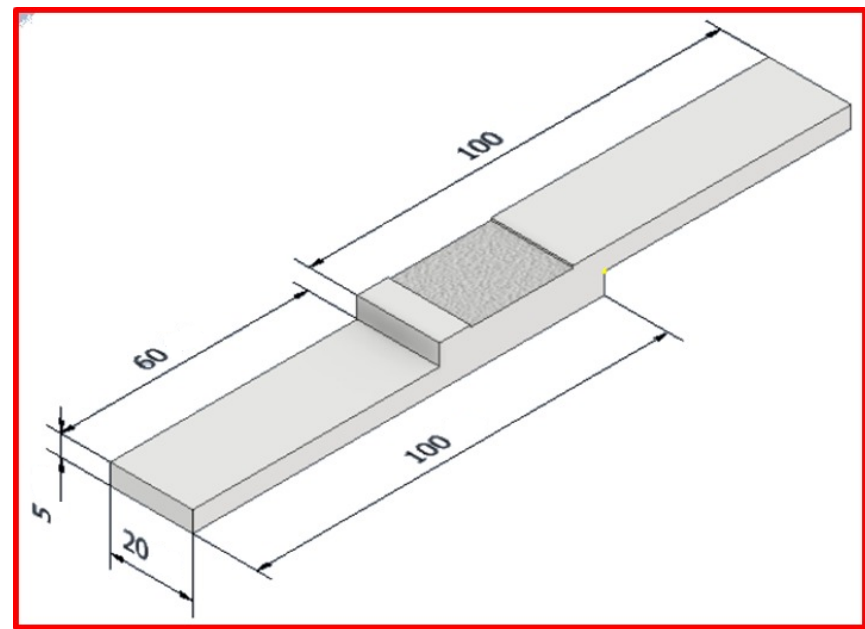
Figure 3. Dimensions of tensile shear lap joints. (Dimensions are in mm) Table 2. Nominal chemical composition and mechanical properties of aluminum alloy AA1050-H14. Elements in wt.%